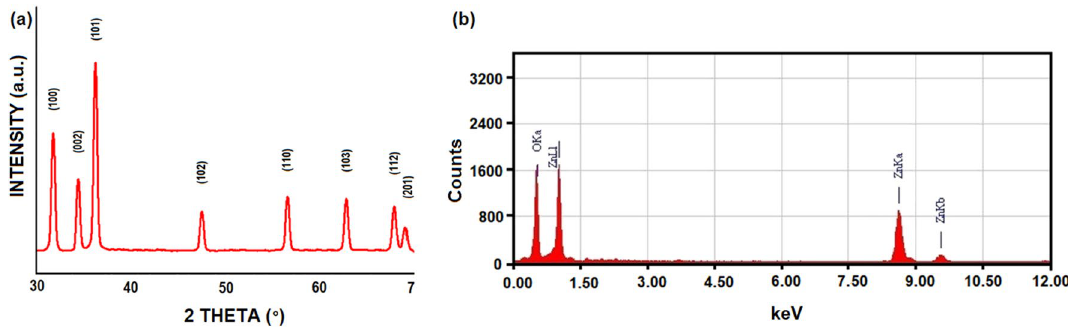
Figure 1. ( a ) X-ray diffraction pattern and ( b ) EDX as synthesized ZNsw via sol–gel